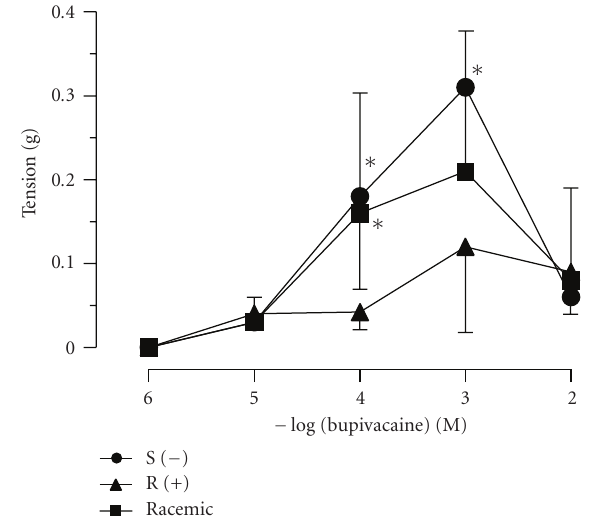
Figure 1: Changes in vascular tension provoked by S( − )-, R(+)-, and racemic bupivacaines. ∗ : P < . 05 versus R(+)-bupivacaine. n = 8.